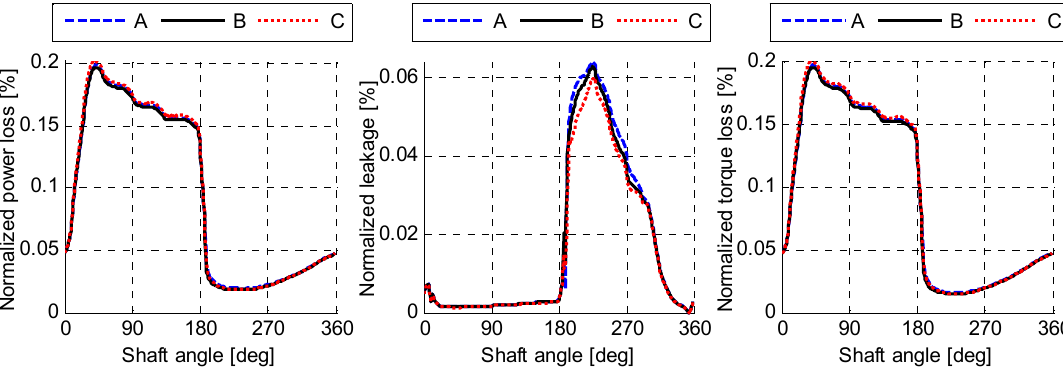
Figure 25. Normalized slipper/swashplate interface performance for different size units.